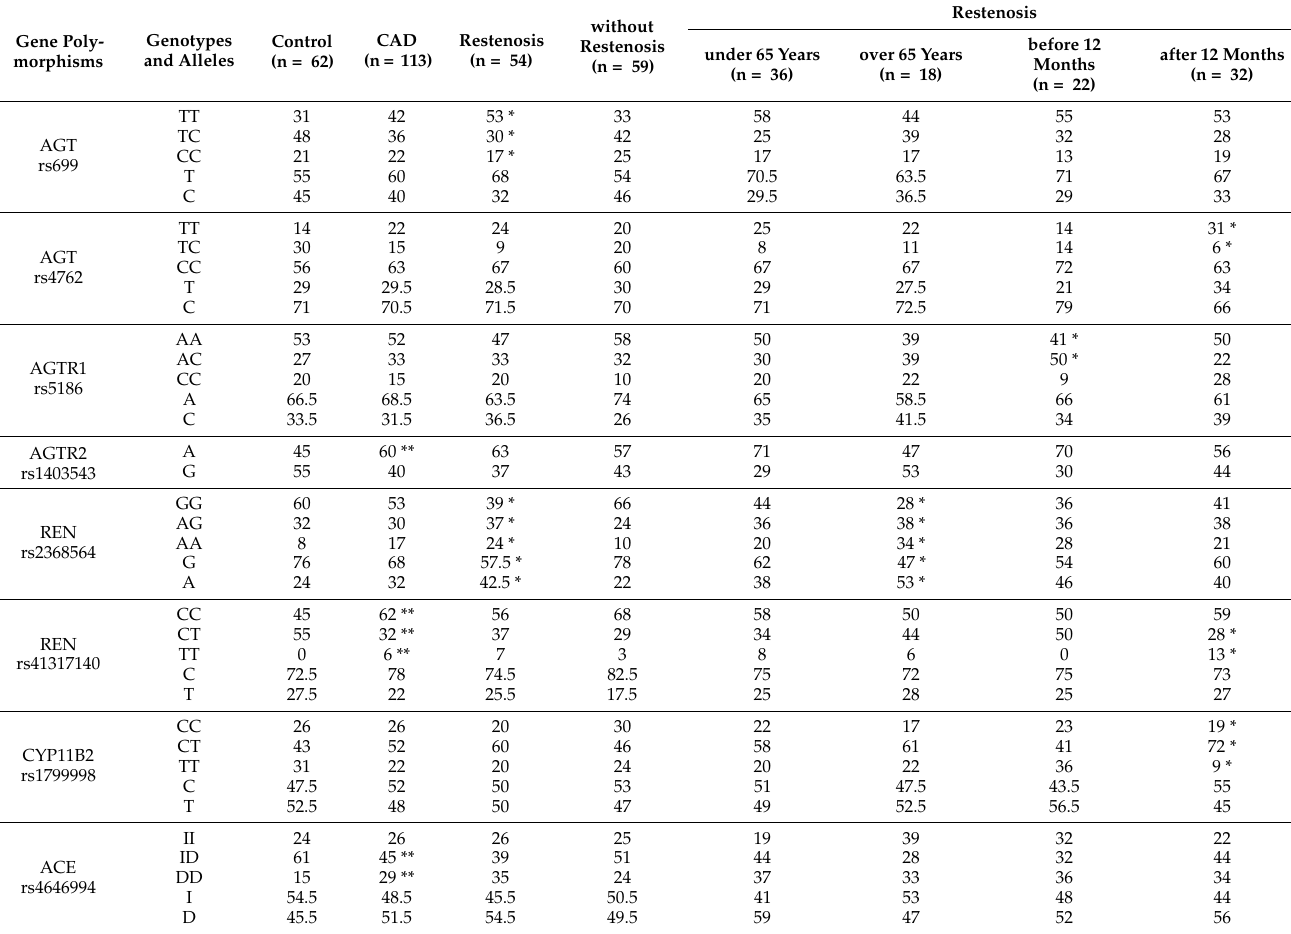
Table 2. Frequencies of alleles and genotypes (%) for polymorphisms of RAAS genes in studied groups. Genotypes Gene Poly- and morphisms